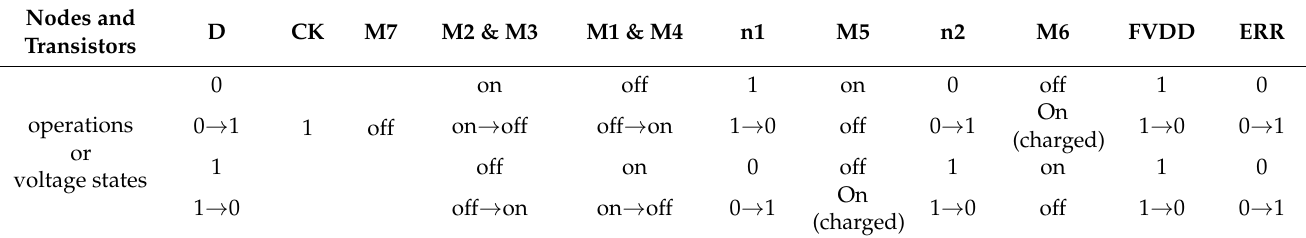
Table 1. Operation of the proposed NTSD